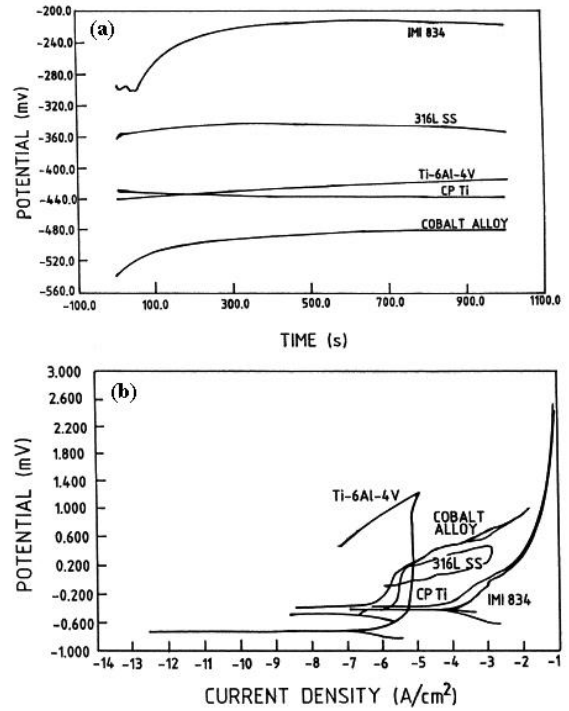
Figure 13. ( a ) OCP versus time and ( b ) cyclic potentiodynamic polarization curves of 316L stainless steel, Co-Ni-Cr-Mo alloy, CP-Ti, Ti–6Al–4V alloy and IMI 834 T-based alloy. Tests were conducted in deaerated Hank’s solution at 37 ◦ C [185]. Reprinted with permission of Elsevier.